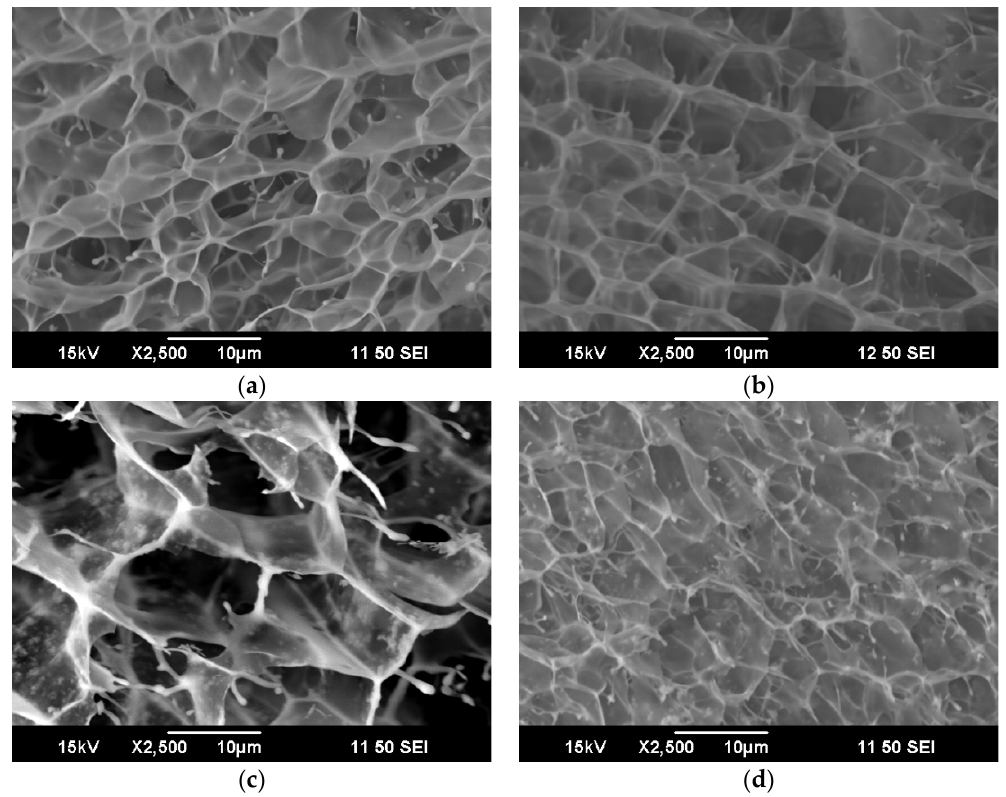
Figure 4. SEM images showing the pore structure of each of the substrates: ( a ) alginate, ( b ) composite A, ( c ) composite B, ( d ) composite C. Scale bar 10 µm.